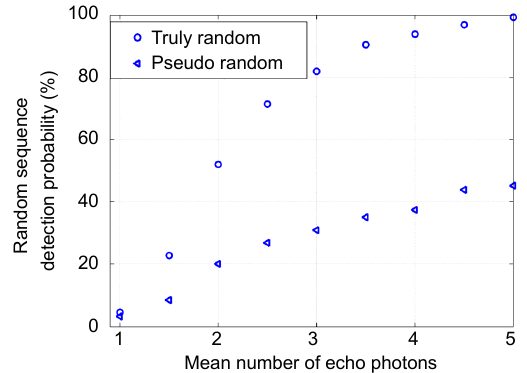
Fig. 5 | The detection probability statistical results of the true random coded method and the pseudo-random coded method at different mean echo photons number.